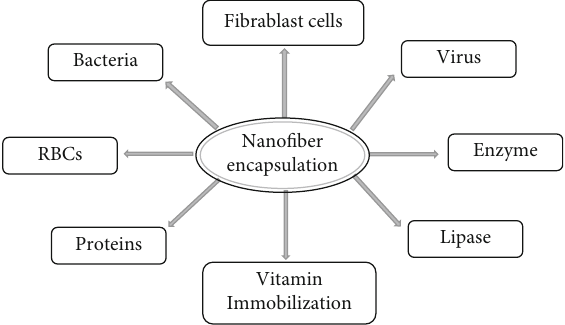
Figure 3: Microorganisms and molecules which can be encapsulated in nano fi